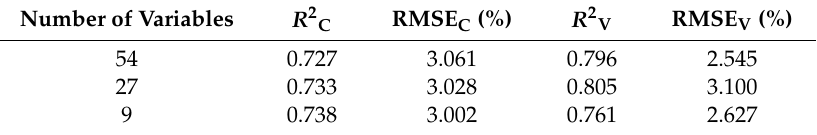
Table 5. Accuracy evaluation of the variable importance in projection (VIP)